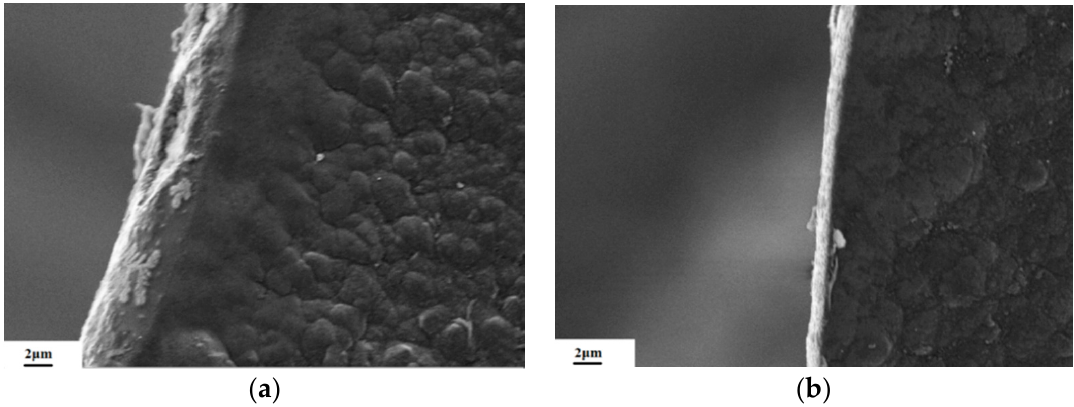
Figure 9. Worn morphology of cutting edge for NCD coated tools. ( a ) n = 4000 rpm, f = 0.004 mm/r; ( b ) n = 6000 rpm, f = 0.008 mm/r.